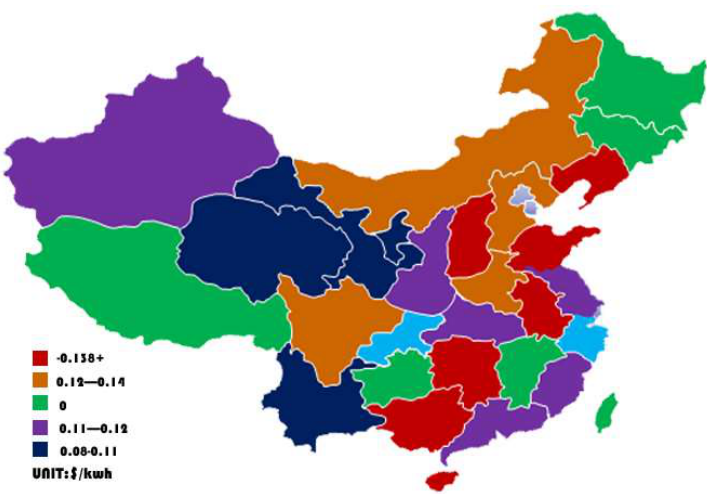
Figure 19. The LCOE of centralized NGPG in base load in China.